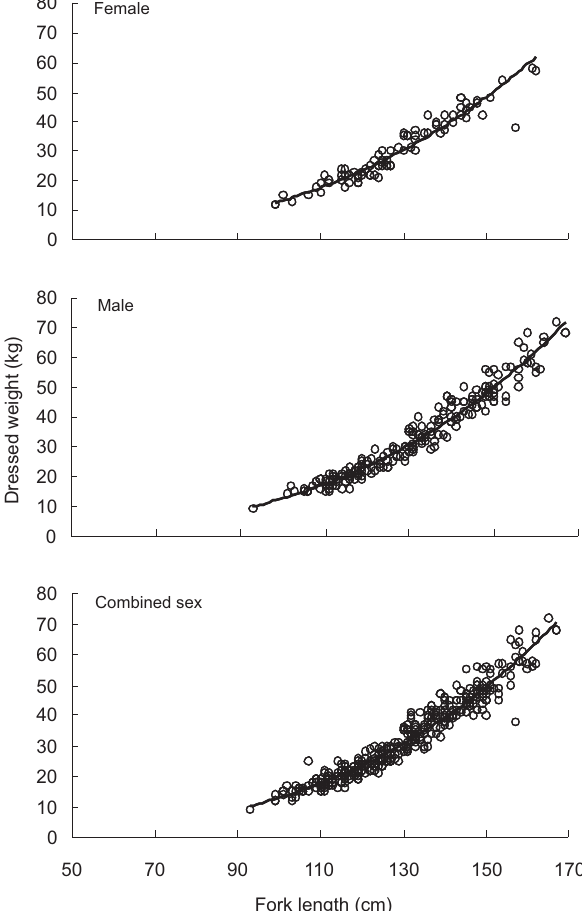
Figure 3. Length frequency distribution of yellowfin tuna in the eastern and central Pacific Ocean from February to November 2006.